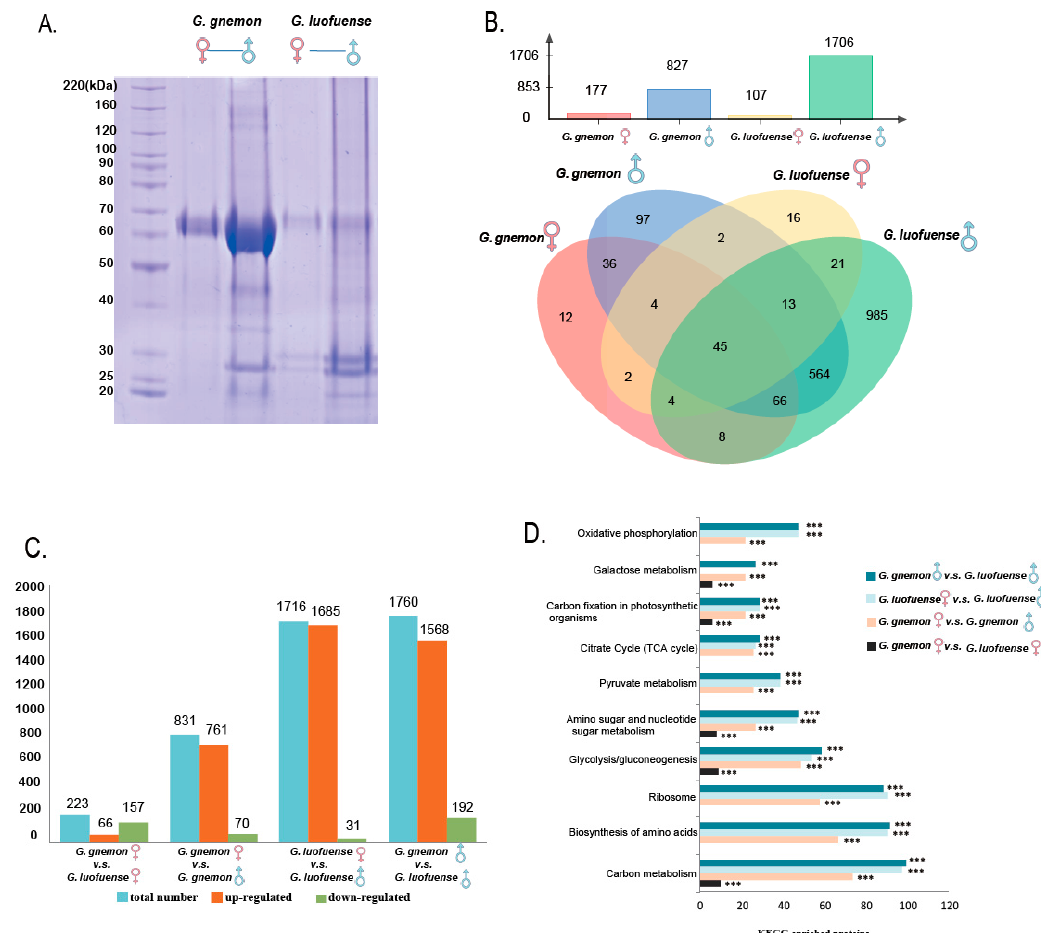
Figure 2. Proteomic data ofthe pollination drops of Gnetum . ( A ) Results of SDS-PAGE reveal the diversity and concentration of proteins in female and male drops of G. gnemon and G. luofuense . ( B ) Protein number detected in the female and male drops of G. gnemon and G. luofuense (above) and as a Venn graph (below), revealing the identical and di ff erential proteins between the female and male drops of the two species. ( C ) Infra- and interspecific variation of di ff erentially abundant proteins (DAPs) between the female and male drops of G. gnemon and G. luofuense . ( D ) These DAPs enriched in the top 10 Kyoto Encyclopedia of Genes and Genomes (KEGG) pathways; *** denotes corrected p values < 0.05.